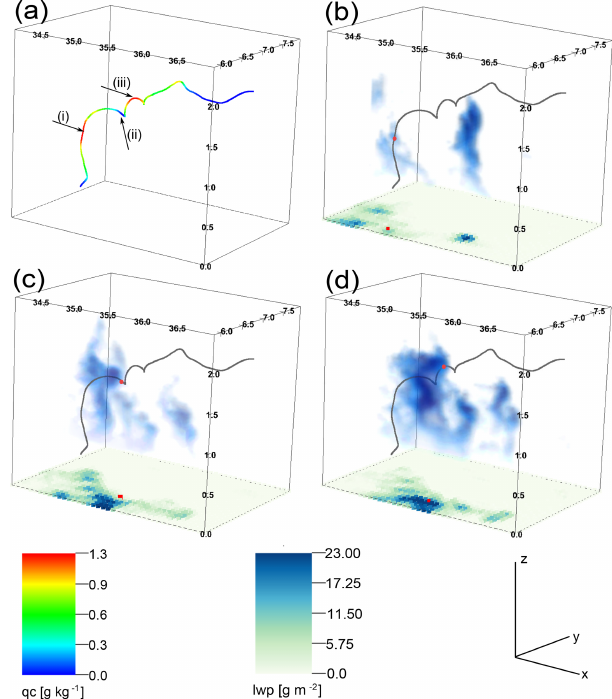
Figure 4. The three-dimensional visualization of q c , the parcel po- sition and liquid water path (lwp) of the selected scene. (a) shows the parcel trajectory. The q c at each time step of the selected par- cel is colored. Three time intervals were selected for the following figures: time intervals where the parcel stays in high- q c areas (i, iii) and one where the q c drops substantially but does not reduce to zero (i). (b) , (c) and (d) show the parcel trajectory (gray, again time dependent). For the time interval in focus, the q c is again colored. The displayed clouds are chosen at the center time of the interval, as is the lwp. The red marker displayed in the lwp field shows the projected location of the center time